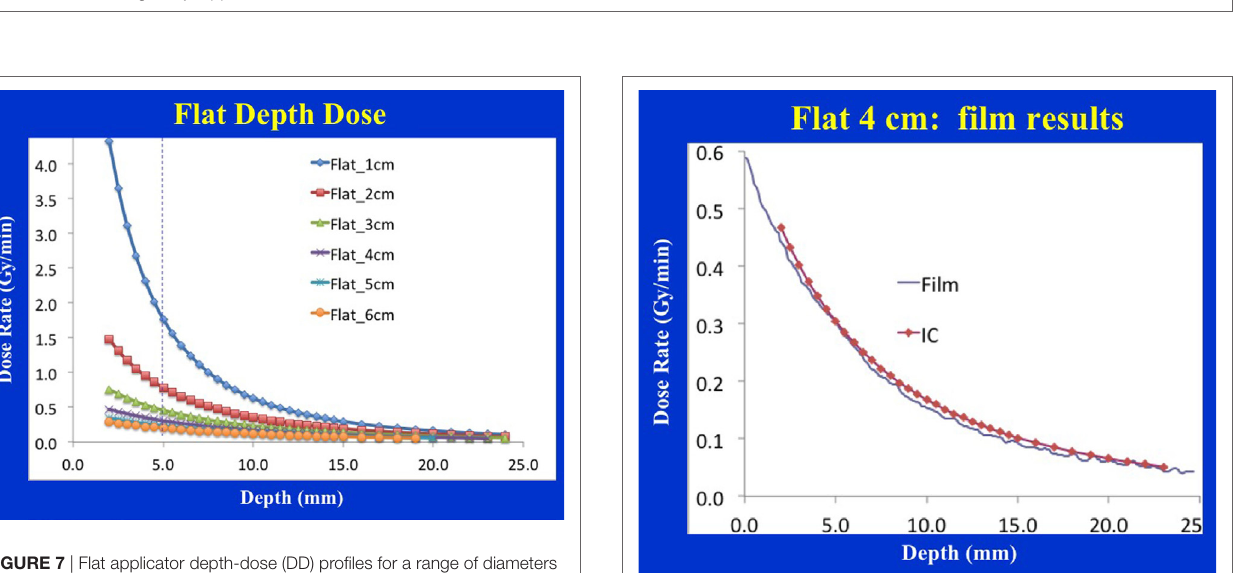
FigUre 7 | Flat applicator depth-dose (DD) profiles for a range of diameters (1–6 cm) as measured with an ion chamber. Larger applicators are characterized by superior dose homogeneity, lower surface dose, smaller output factor, and longer treatment times. Notice a lack of measured data at shallow depths ( < 2 mm) due to the chamber